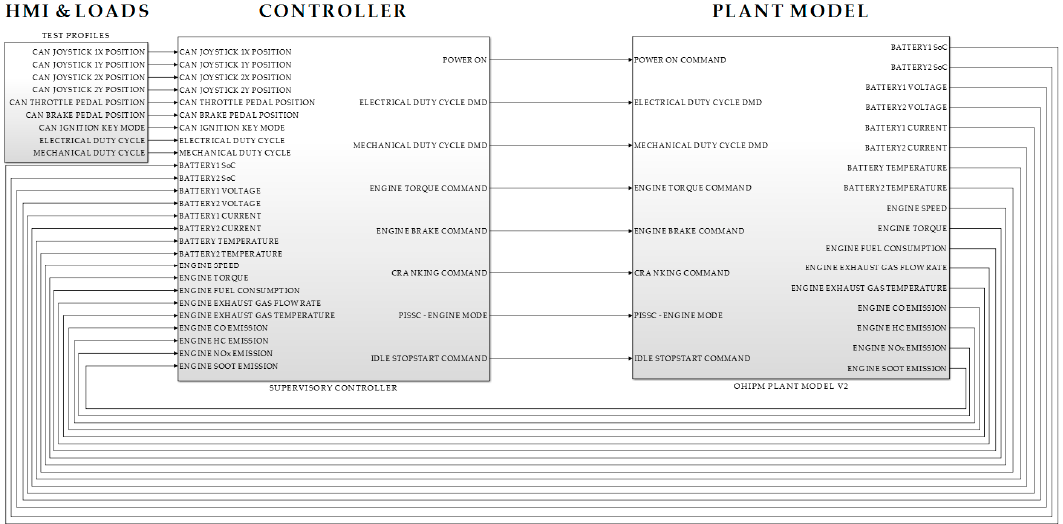
Figure 14. Complete Simulink control system for simulations.